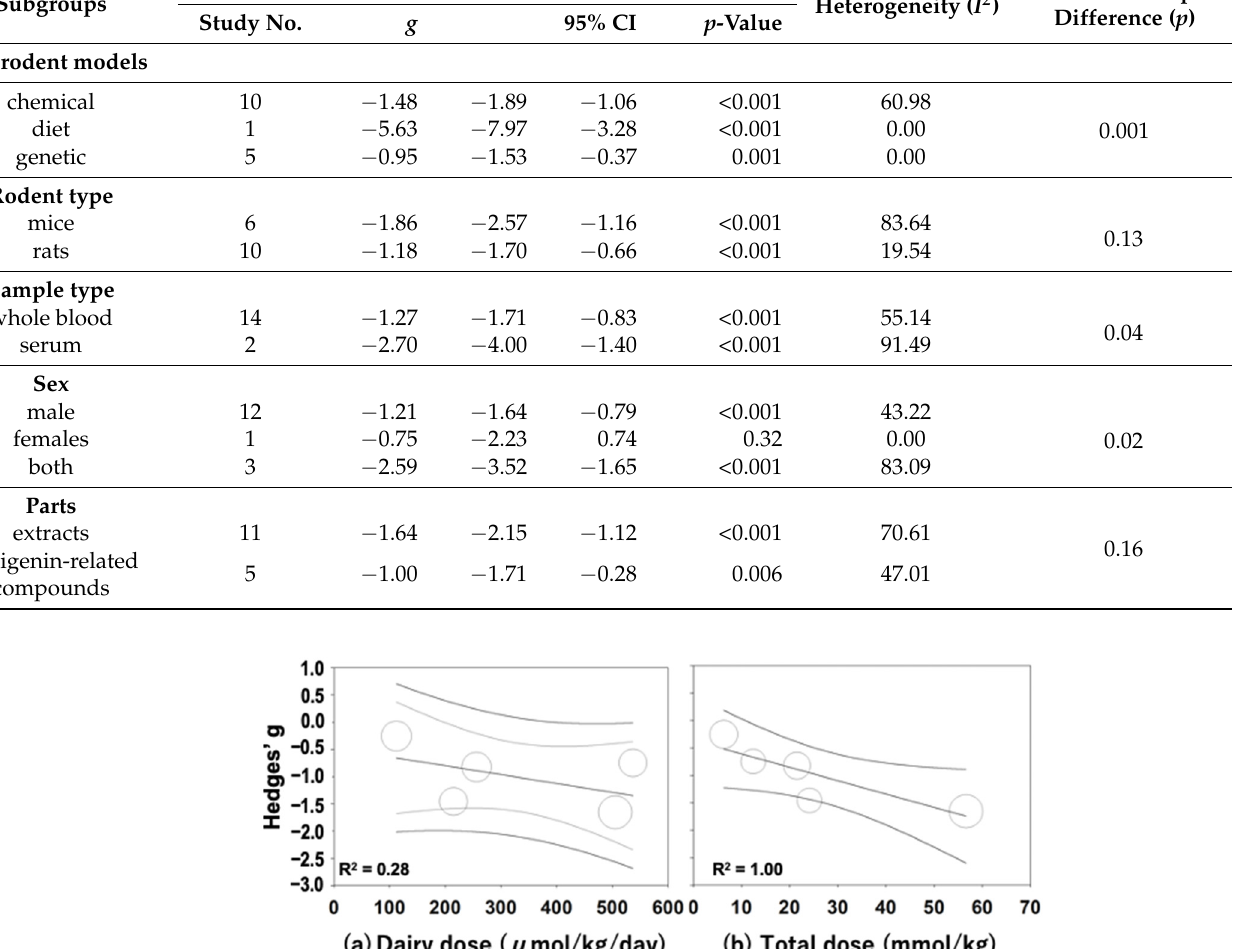
Figure 3. Meta-regression analyses for Hedges’ g of BG levels and daily ( μ mol/kg/day) ( a ) or total doses (mmol/kg) ( b ) of arctigenin-related compounds. R 2 values explain how much daily or total doses of arctigenin-related lignans influence the heterogeneity among DM rodents treated with those compounds (I 2 = 47.01 in Table